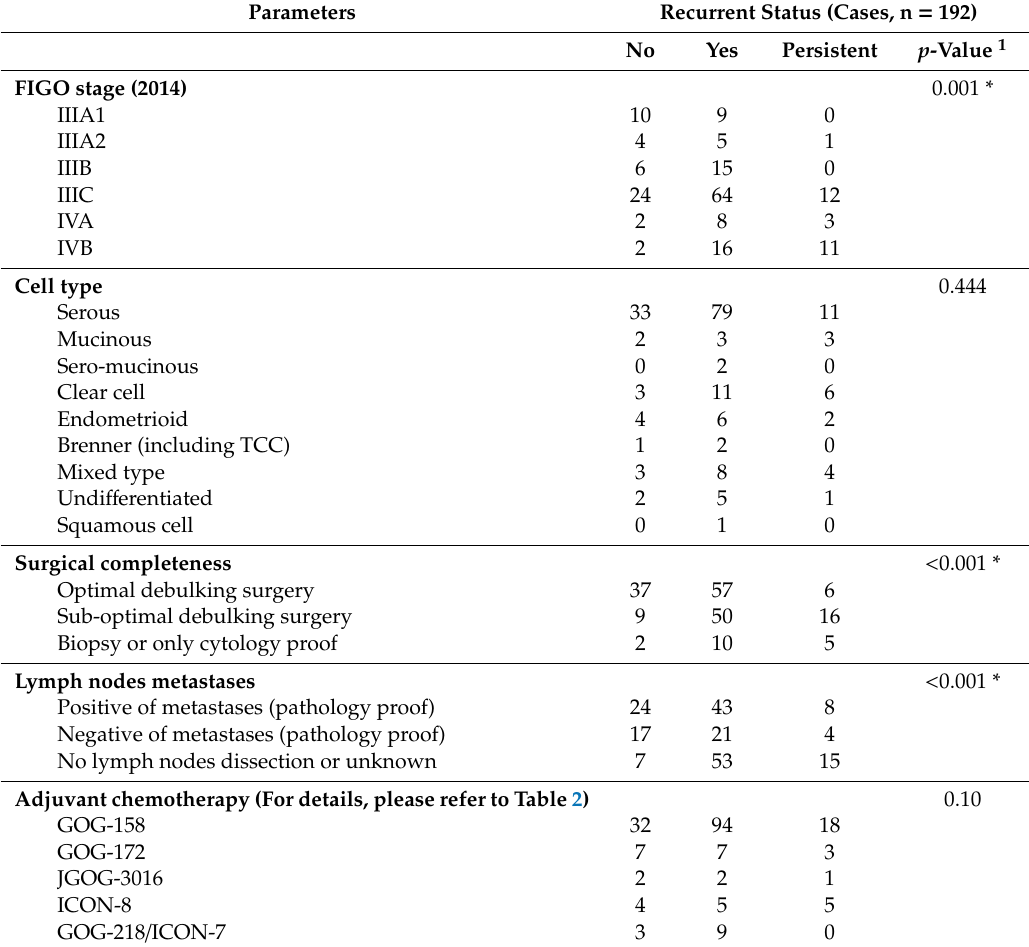
Table 4. Parameters a ff ect recurrent / persistent status in all enrolled